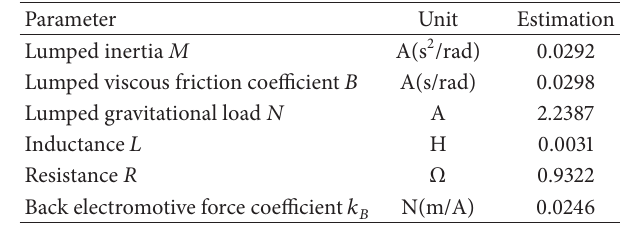
Table 3: Performance of the two controllers: maximum peak-to- peak value (PTPV) of the tracking errors after the settling time.